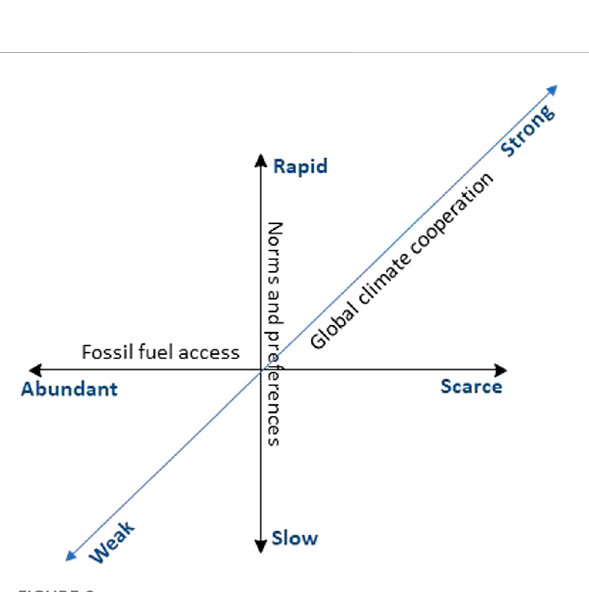
FIGURE 2 Axes of the scenarios. Source; Fæhn and Stoknes